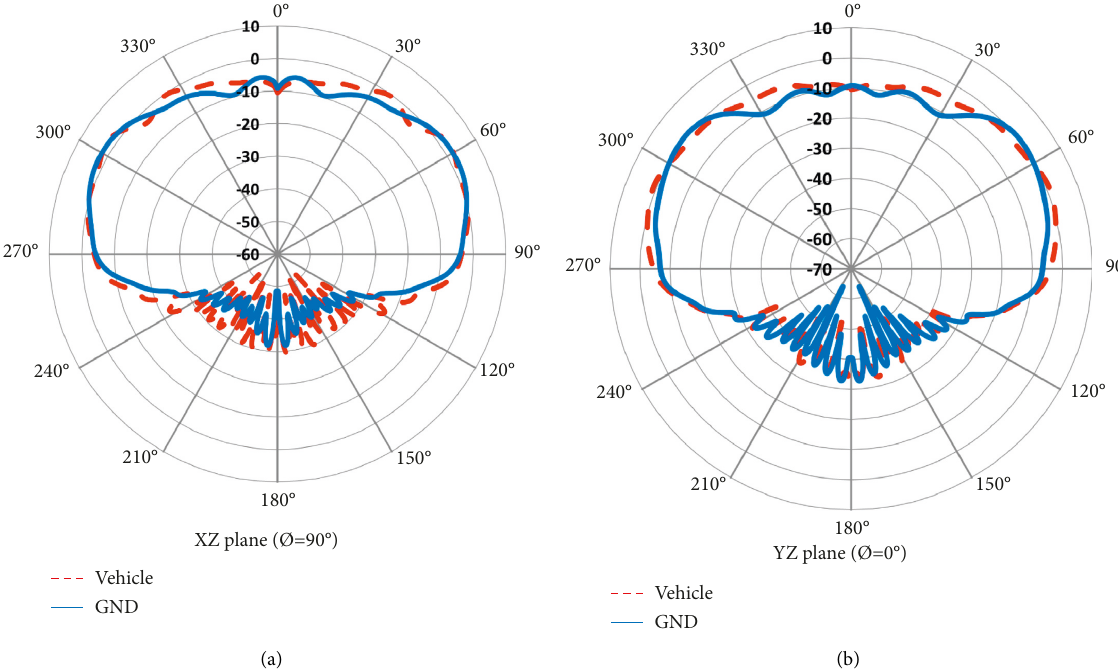
Figure 17: GNSS passive RHCP gain in the XZ and YZ planes at 1575MHz measured on ground plane and vehicle. (a) XZ plane (Ø � 90 ° ). (b) YZ plane (Ø � 0 °